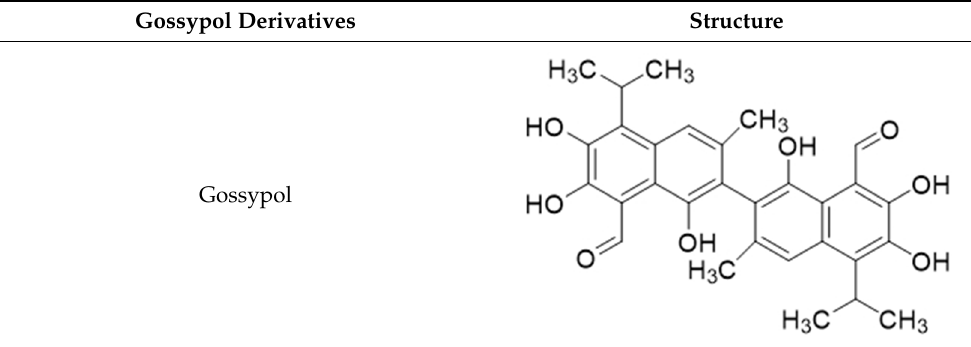
Figure 2. Structures of the gossypol enantiomers: ( A ) and ( B ), absolute configuration of gossypol atropisomers; ( C ) ( aR )-gossypol (M) ( − )-1; and ( D ) ( aS )-gossypol (P) (+)-1.